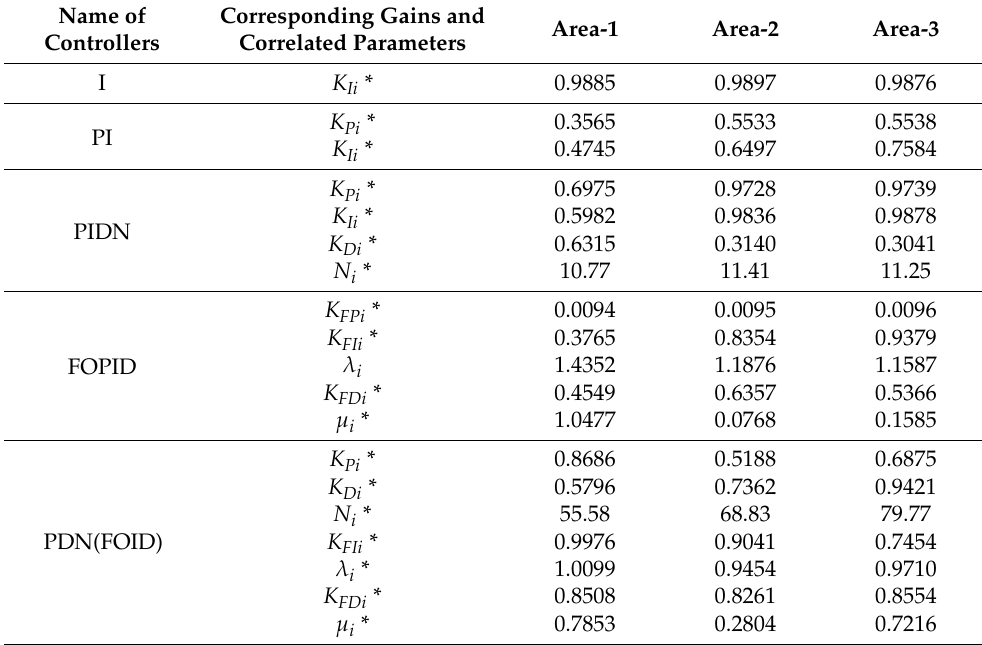
Table 1. Finest values of gains and related parameters of subordinate controllers for scheme-1.